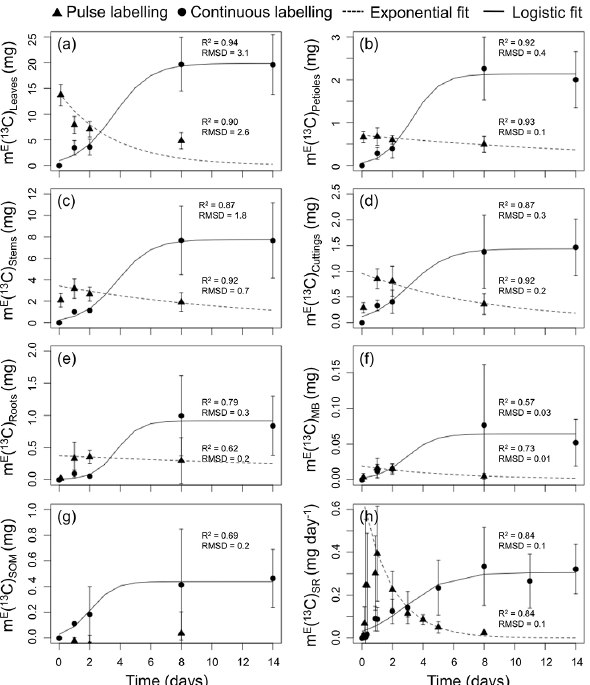
Fig. 2. Dynamics in the 13 C distribution. 13 C label recovered after the pulse and during the continuous exposure of the plants to 13 CO 2 in leaves (a) , petioles (b) , stems (c) , cuttings (d) , roots (e) , micro- bial biomass MB (f) , soil organic matter SOM (g) and in the soil respiration SR (h) expressed as mass of 13 C in excess m E (mg 13 C and mg 13 Cday − 1 ). Error bars indicate ± one standard deviation of the three plant individuals. The best fits (nonlinear least squares) are given for the exponential function after pulse labelling and for the logistic increase during continuous labelling. The coefficient of determination ( R 2 ) and the root-mean-square-deviation (RMSD) were calculated with the individual measurement points. A sensitiv- ity analysis of the logistic model fit can be found in the